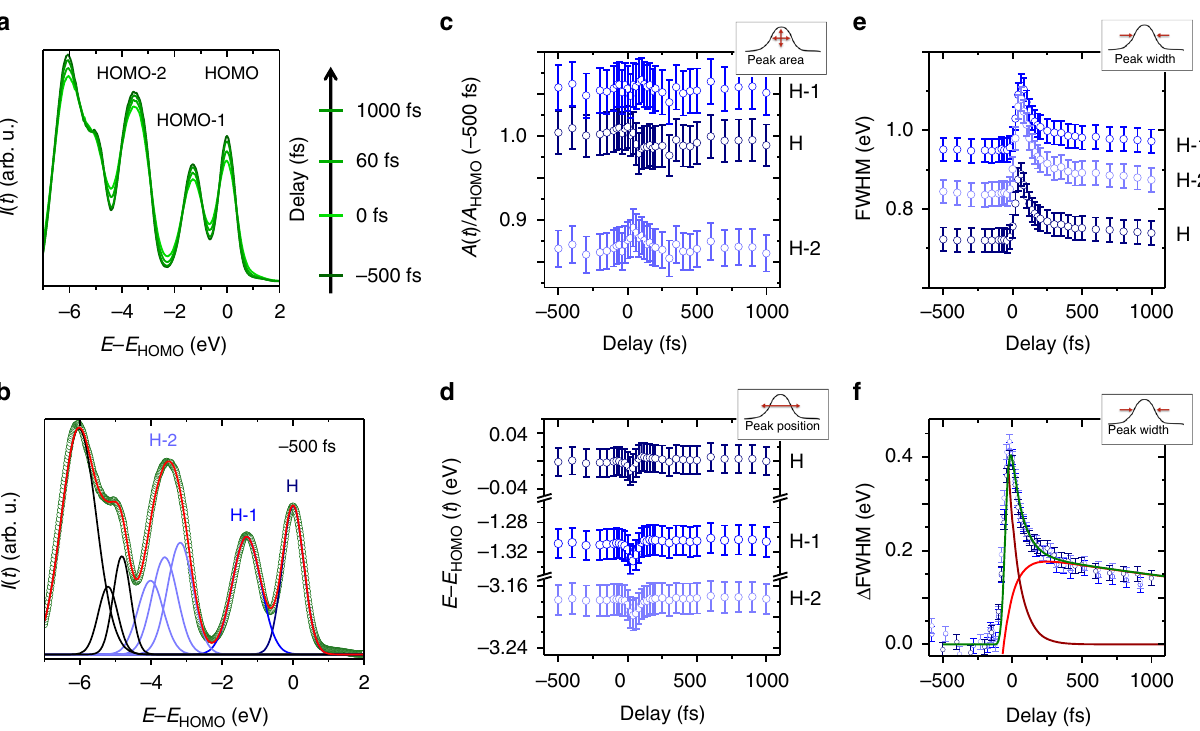
Fig. 3 Transient spectral changes of the occupied valence band structure of C 60 /Ag(111). a Selected energy distribution curves (EDCs) of the occupied molecular valence band structure (HOMO-X levels) at characteristic time steps. The line shape of these EDCs are analyzed separately at each time step by a dedicated fi tting model shown in panel b . The corresponding fi tting parameters normalized intensity A , binding energy position E − E HOMO , and full width half maximum (FWHM) of each spectroscopic feature are presented in panels c – e . The error bars represent the uncertainty of the fi tting parameter in the fi tting routine used to analyze the valence band spectra. f Transient broadening (relative change of the FWHM) of each HOMO-X level. These curves are calculated by separating the static broadening of the spectroscopic levels prior to the optical excitation from the optically induced change of the FWHM. The error bars are obtained by propagation of the uncertainties of the original data sets. The solid lines represent a fi tting model used to extract the temporal evolution of the transient broadening ( Δ FWHM). The data were obtained for a C 60 coverage of 10 ML and a laser fl uence of F = 40 ± 12 µ J cm −